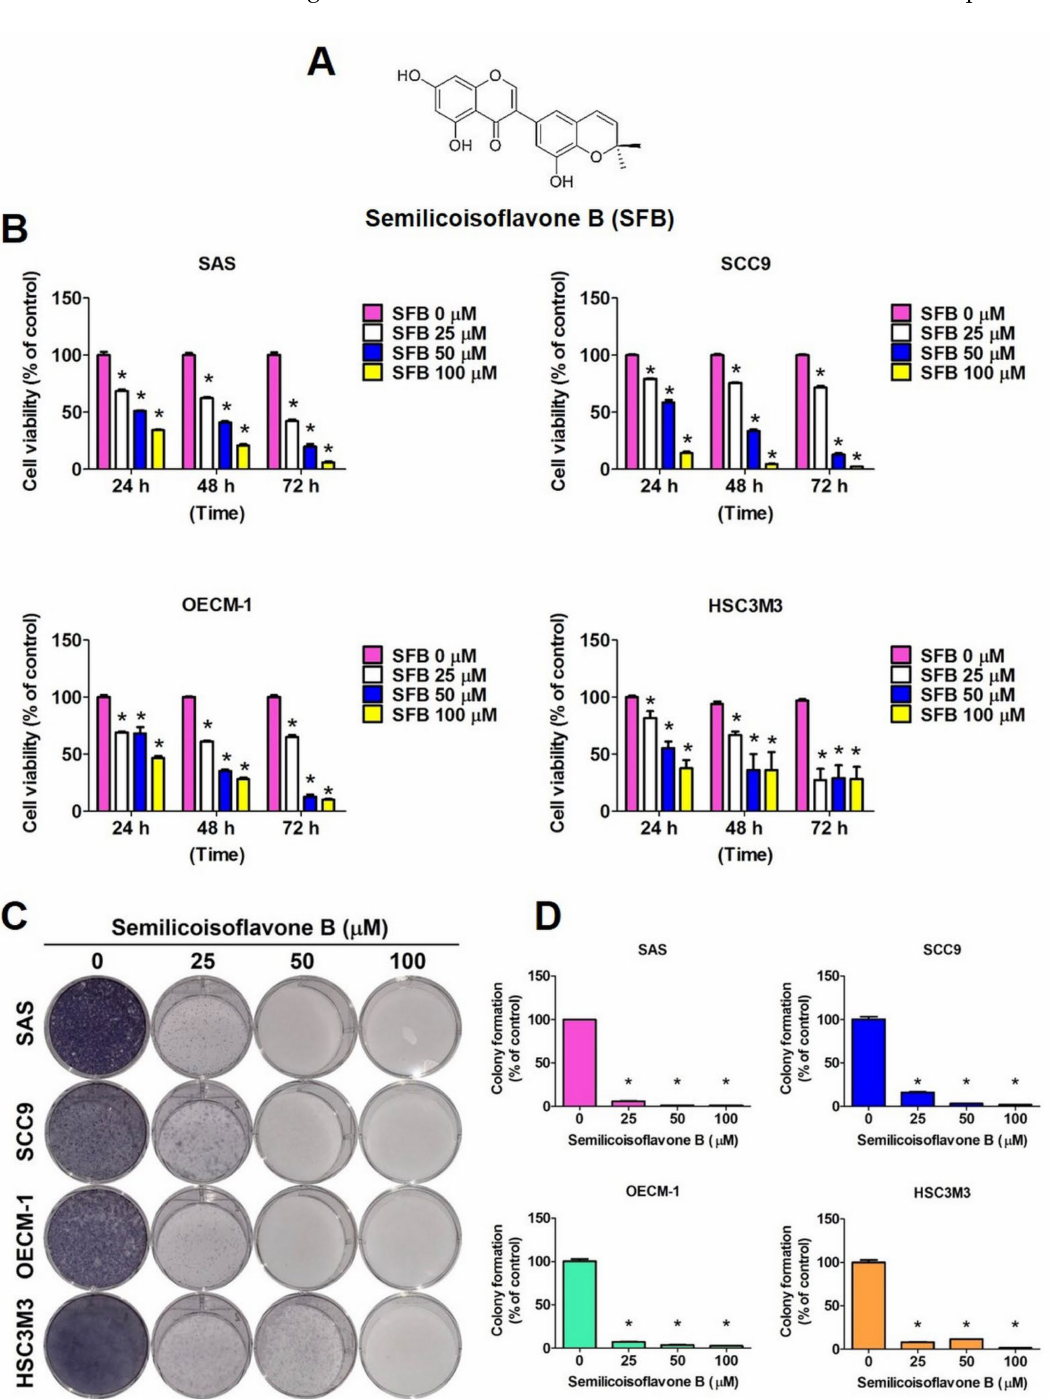
Figure 1. Toxicity of semilicoisoflavone B on oral cancer cells. ( A ) Chemical structure of semilicoisoflavone B (SFB). ( B ) Results of the MTT assay for oral cancer cells (SAS, SCC9, OECM-1 and HSC3M3) treated with indicated concentrations of semilicoisoflavone B for 24 h. ( C , D ) Results of the colony formation